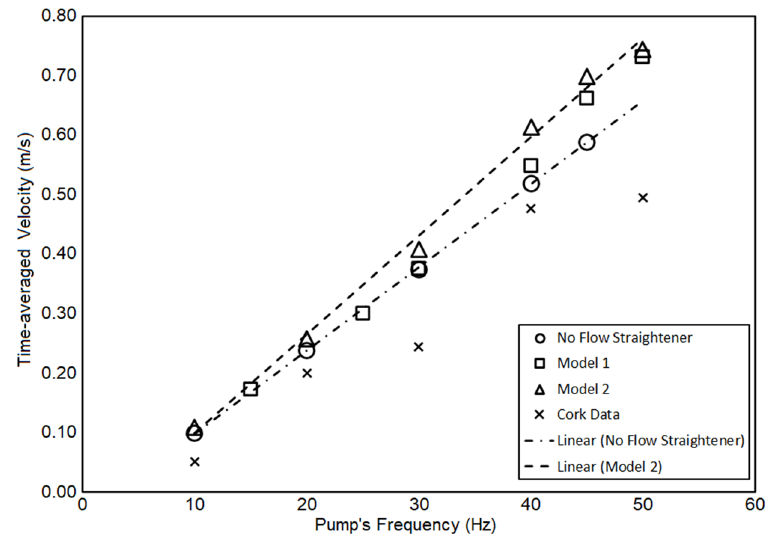
Figure 14. This figure shows the comparison of time-averaged velocity data versus pump’s fre- quency. The data are obtained using Models 1 and 2 of the flow straighteners. The data from measuring the water velocity using floating cork are presented using cross symbols. Data from Model 1 shows minimal deviation from the reference data. The cork data underestimates the refer- ence data, but it gives good estimate for a quick verification of the flow meter.